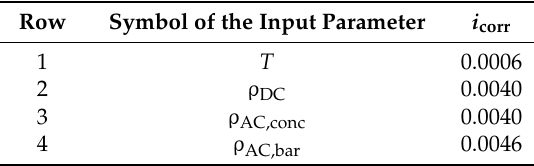
Table 7. Analysis of the sensitivity of the output in the SOFM–GA model in comparison to the input parameters.